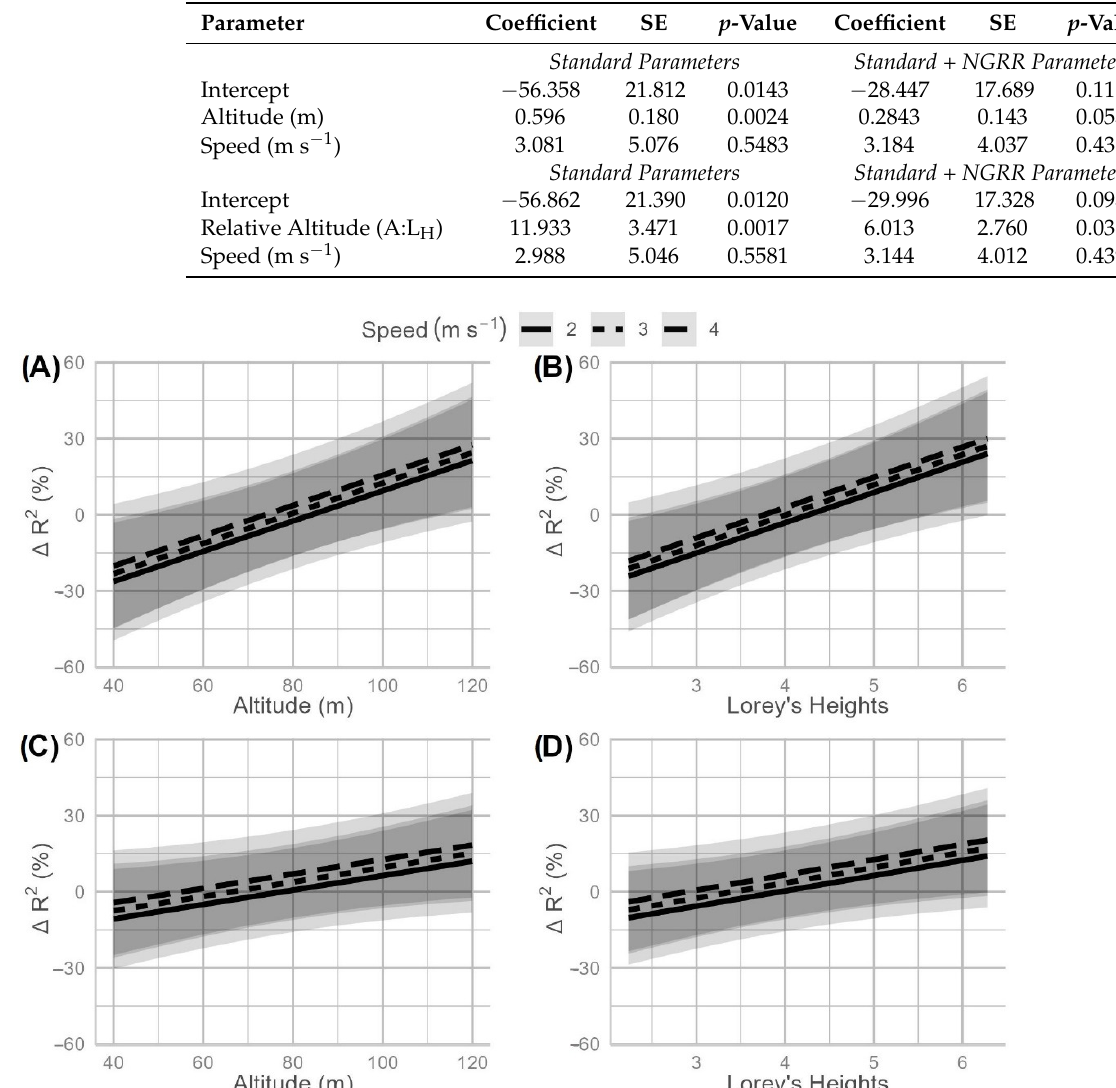
Figure 4. Linear mixed-effects model results for the 37 Standard SfM AGB models (panels ( A , B )) and the 37 Standard + NGRR AGB models (panels ( C , D )).